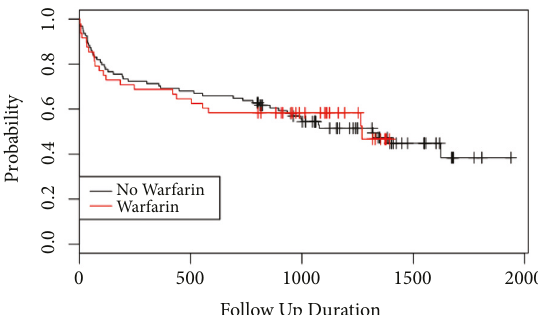
Figure 2: Kaplan-Meier curve of post-guideline matched war- farinised and nonwarfarinised patients during 58-month follow-up (follow-up duration in